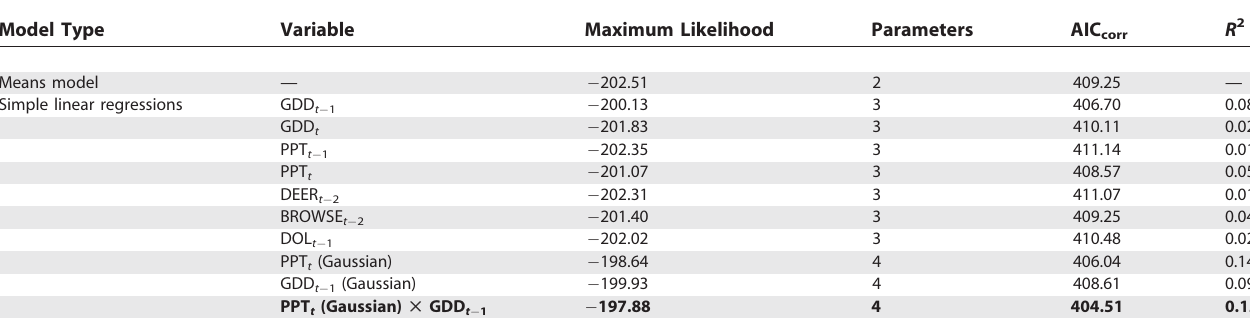
Table 1. Model Comparison Statistics for Independent Variables Potentially Influencing the DON Based on the Full Dataset (58 Plot Years) Model